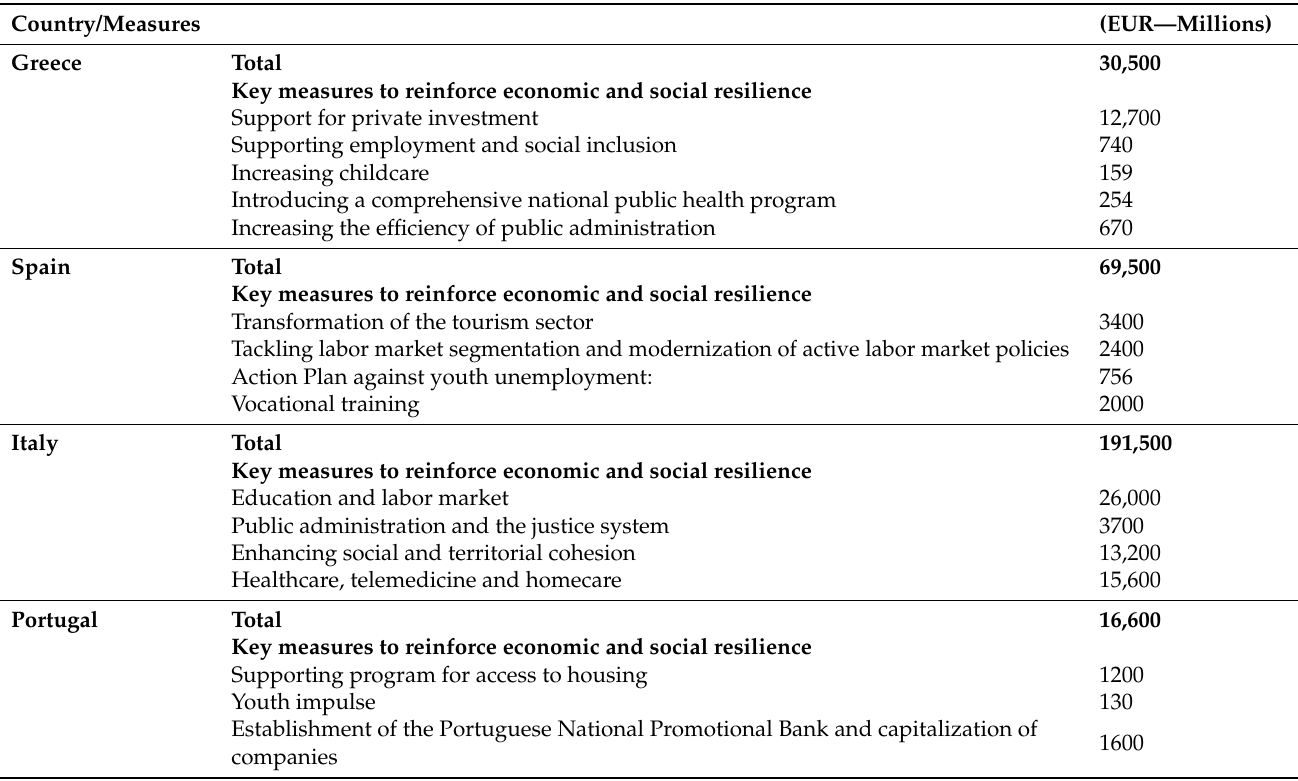
Table 3. Next Generation EU financing to Greece, Spain, Italy, and